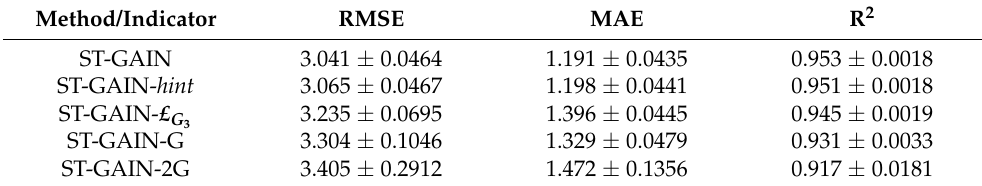
Table 2. Results of ablation